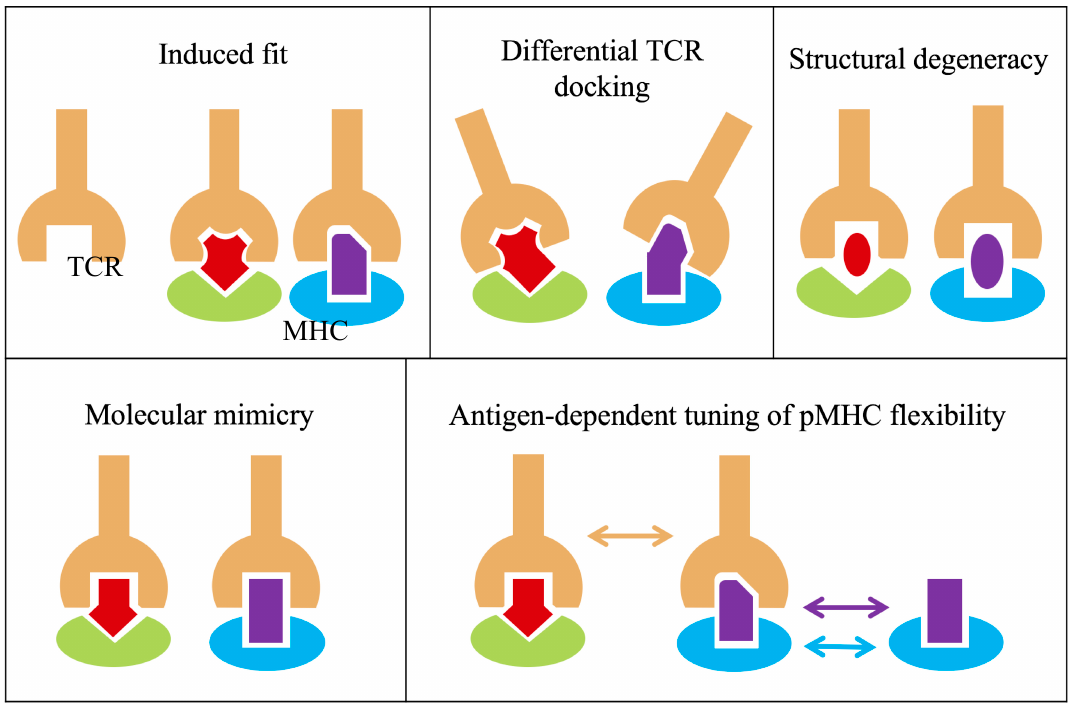
Figure 3. Revisiting T cell receptor-peptide major histocompatibility complex (TCR-pMHC) binding, possible molecular mechanisms of T cell recognition of cross-reactive peptide epitopes. Adapted from [42].